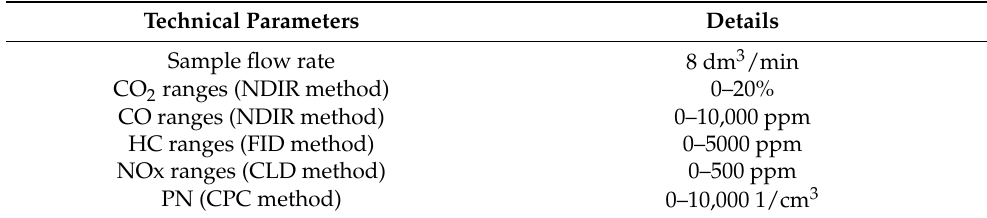
Table 2. The characteristics of the exhaust emission analysers.